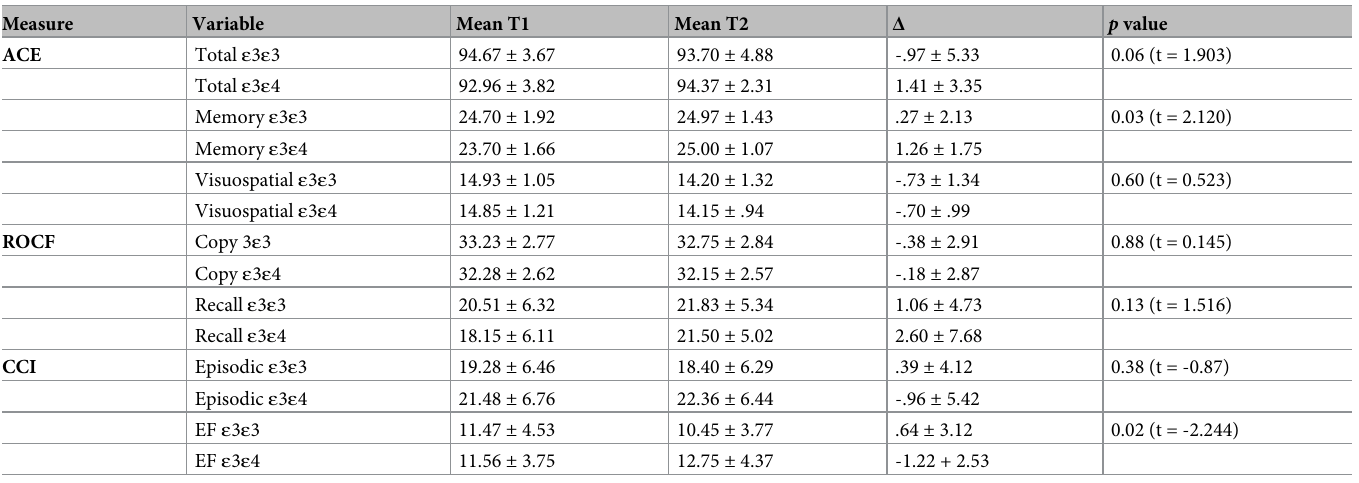
ACE = The Addenbrooke’s cognitive examination; ROCF = Rey-Osterrieth complex figure test; CCI = Cognitive change index; EF; Executive function; T1 = Baseline; T2 = retest; Δ change/difference = T2 value—T1 value; p value = significant change between genetic